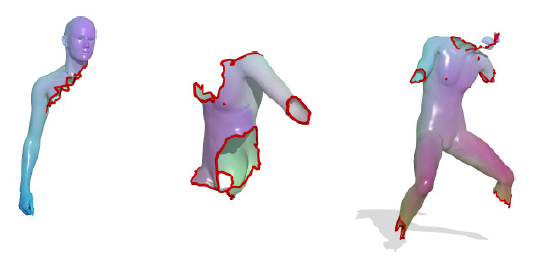
Figure 21. Examples from the Partial Shape Dataset. The figure is originally from the website